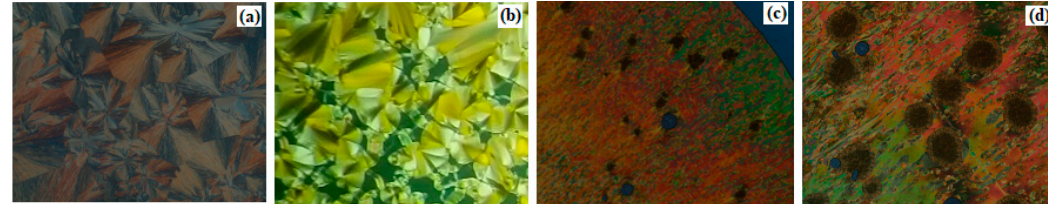
Figure 3. Mesophases textures under polarizing optical microscopy (POM) upon heating of A/2B10 SMHBLC complex ( a ) Solid phase at 100.0 °C; ( b ) SmA phase at 141.0 °C; ( c ) N phase at 158.0 °C and ( d ) N and isotropic phases at 160.0 °C.